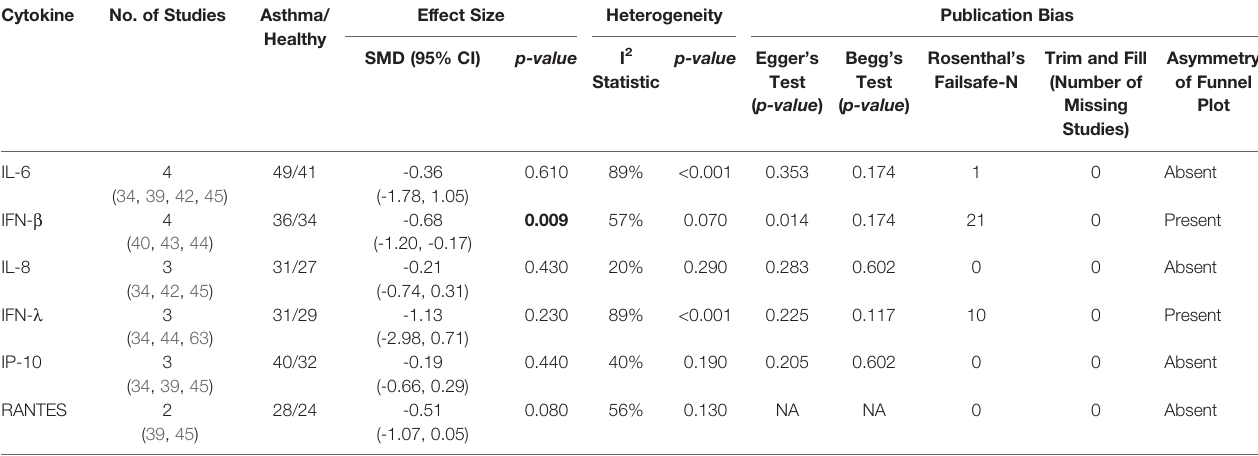
CI, con fi dence interval; SMD, standardized mean difference; NA, not applicable; statistically signi fi cant results are in